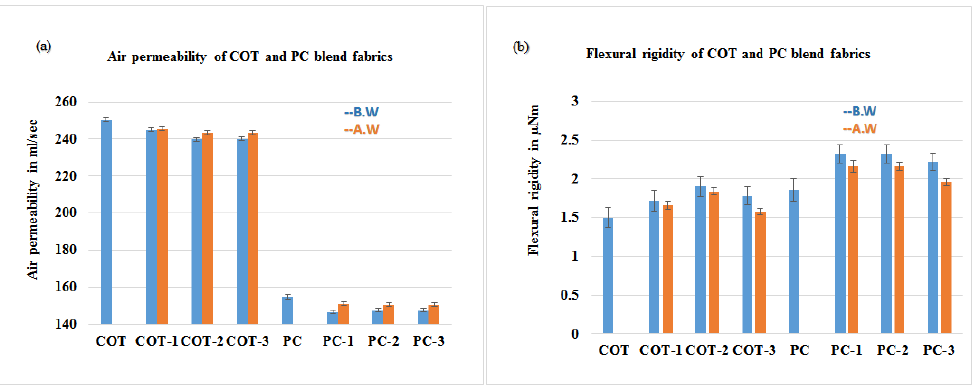
Figure 6. ( a ) Air permeability and ( b ) flexural rigidity of COT and PC fabrics.